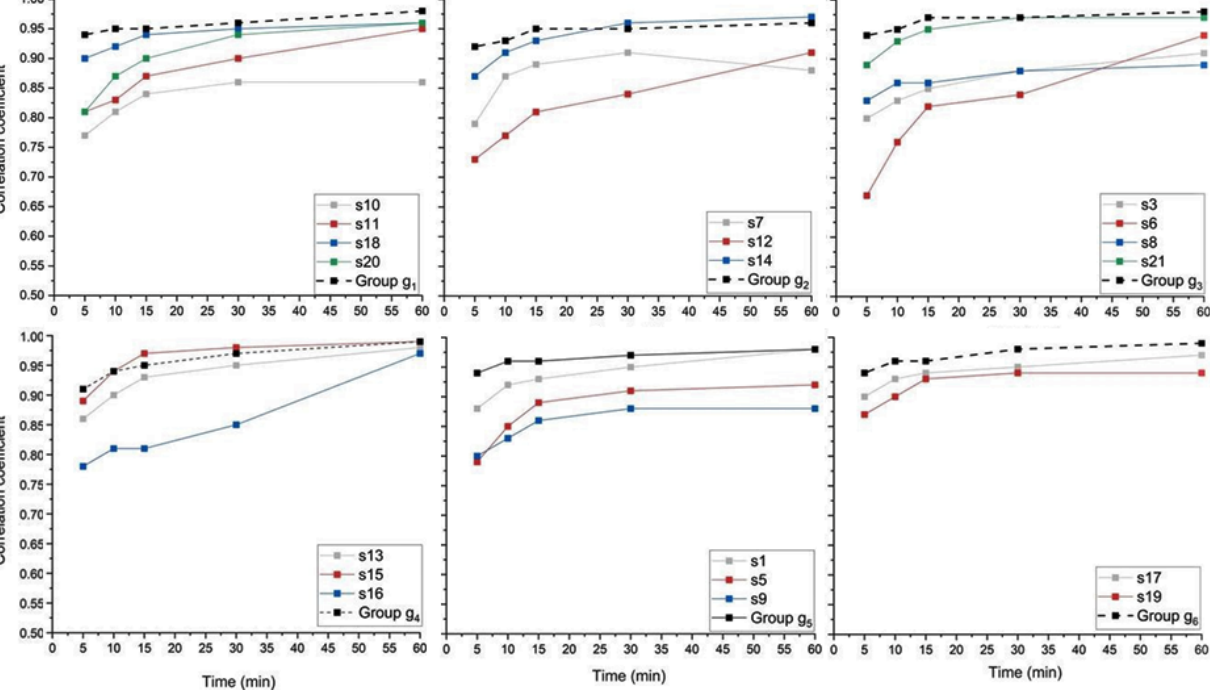
Figure 12. Correlation coefficients between Dynamap predictions and some field measurements vs. update time τ [min], obtained within the six groups ( g 1 − g 6 ), according to normalization procedure P2 (see Figure 10). The black lines illustrate the cross-correlations between the mean group equivalent noise level measurements and respective mean Dynamap (cid:10) ( τ ) ( t , s ( g )) (cid:11) [93]. The location of the site measurements, (s1–s21) is displayed in Figure 6 (see also Table L predictions, eq i